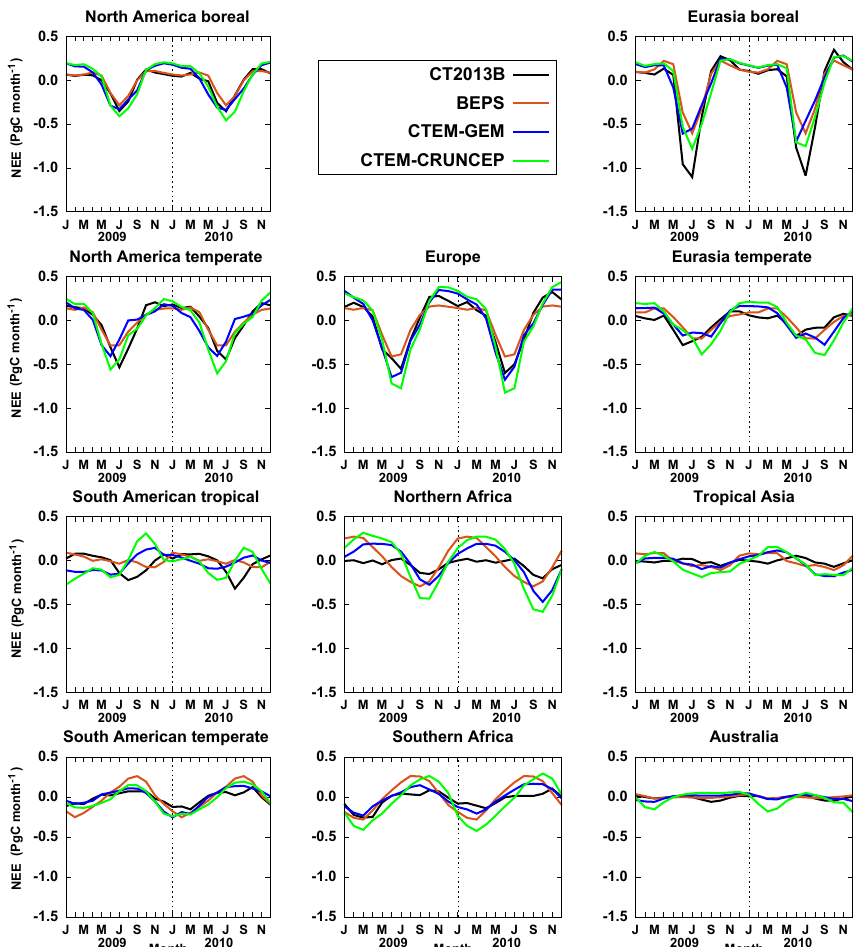
Figure 9. The seasonal cycle of NEE from CTEM-GEM, CTEM-CRUNCEP, and BEPS in comparison to the optimized NEE from CT2013B integrated over the 11 TransCom land